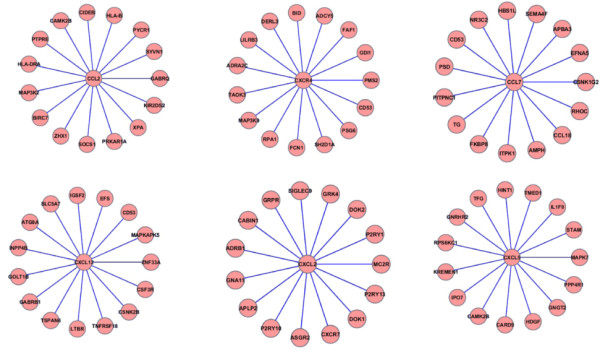
Top network-based biosignature of treatment response in EPCs. Gene composition and interactions of the biosignature "EDQ+15NN", which provided the basis for the best prediction model with 6 neighbourhood expression inputs.